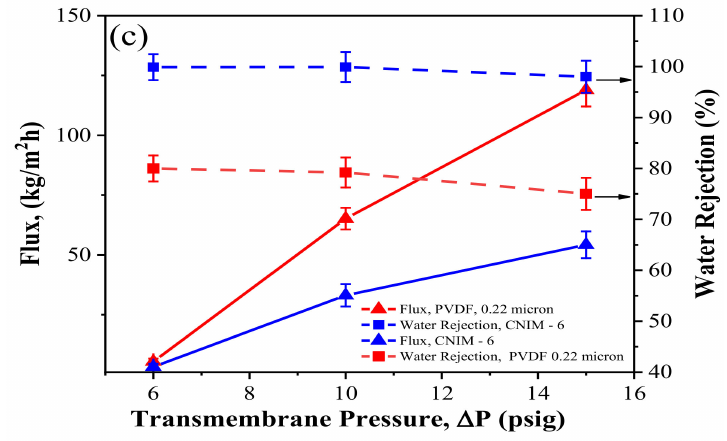
Figure 4. Effect of transmembrane pressure on kerosene flux and water rejection at a feed water concentration of 500 ppm and feed flowrate of 40 mL/min for ( a ) PTFE (0.1 µ m) and CNIM-3; ( b ) PTFE (0.22 µ m) and CNIM-6; and ( c ) PVDF (0.22 µ m) and